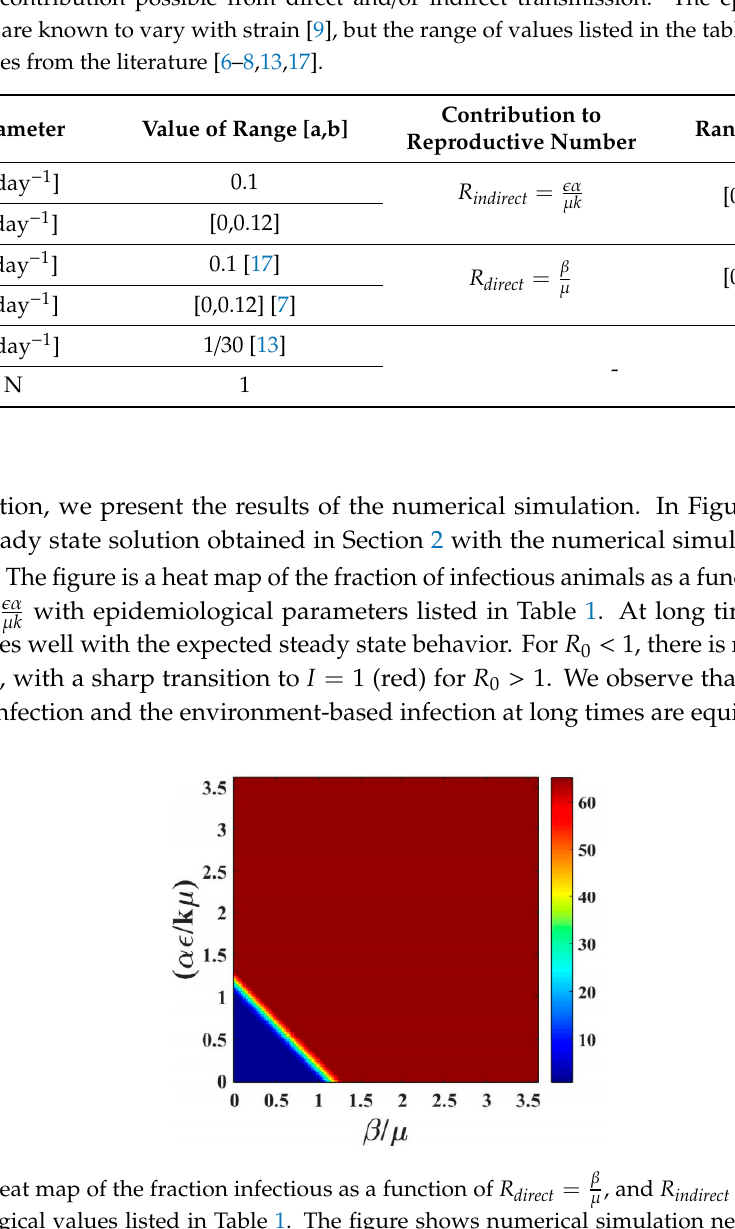
Figure 2. Heat map of the fraction infectious as a function of 𝑅 (cid:3031)(cid:3036)(cid:3045)(cid:3032)(cid:3030)(cid:3047) =